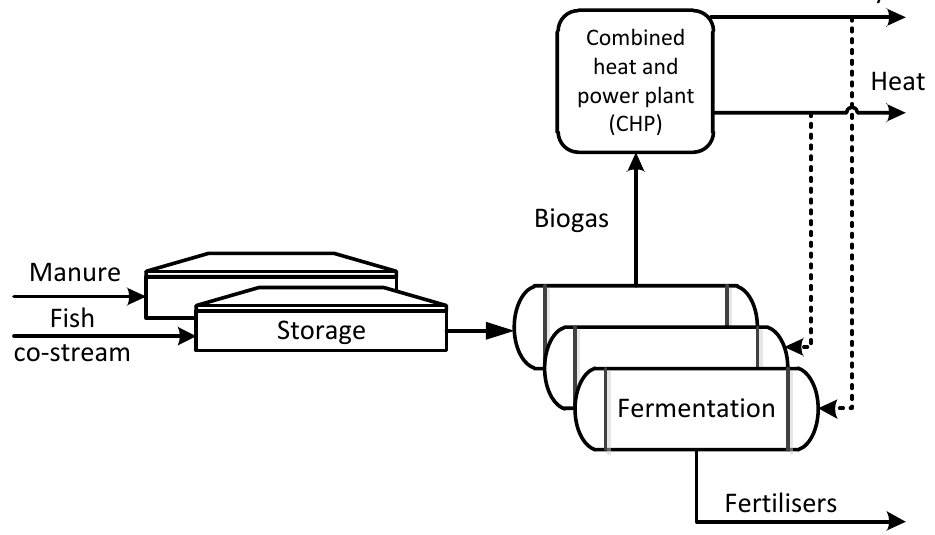
Figure 2. Processing the fish co-stream to biogas and fertilisers (I).